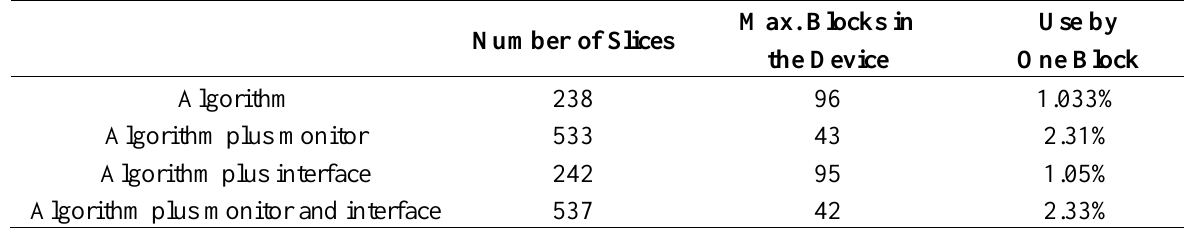
Table 1. Hardware resources consumption by the Spartan 6 1500